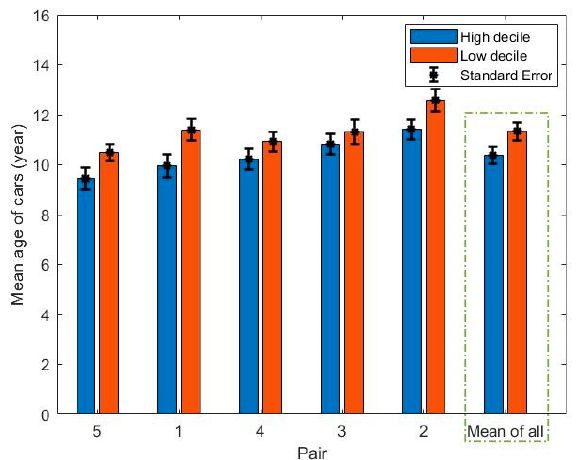
Figure 4. Bar plot displaying the mean age of cars in years for the observed cars in the neighborhood of each school. The error bars are the standard error of the means.